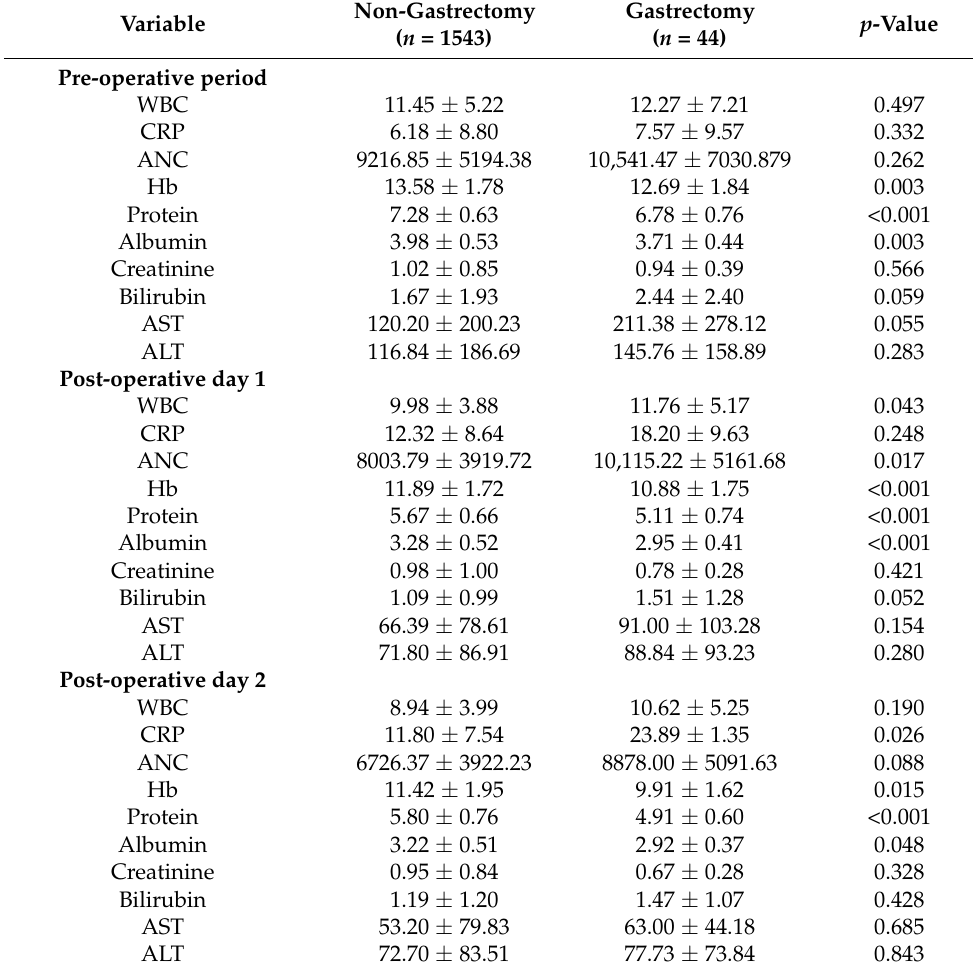
Table 3. Perioperative laboratory